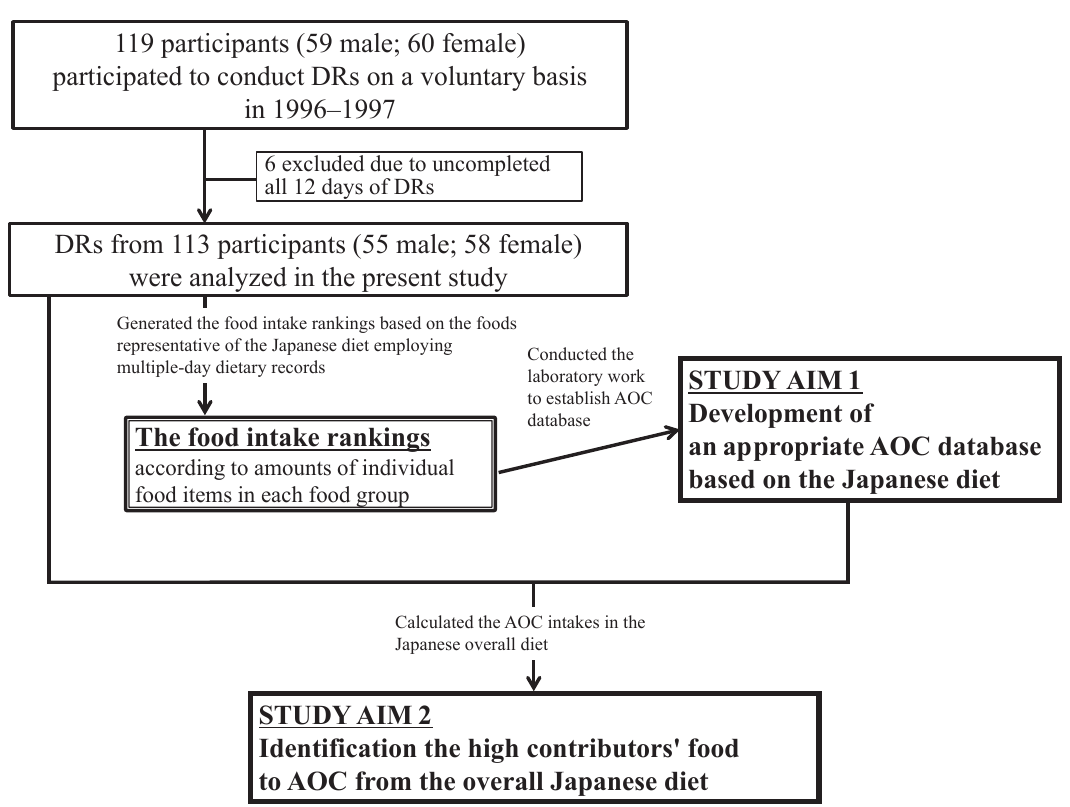
Figure 1. Flow fl owchart of the present study. AOC, antioxidant capacity; DRs, dietary records.